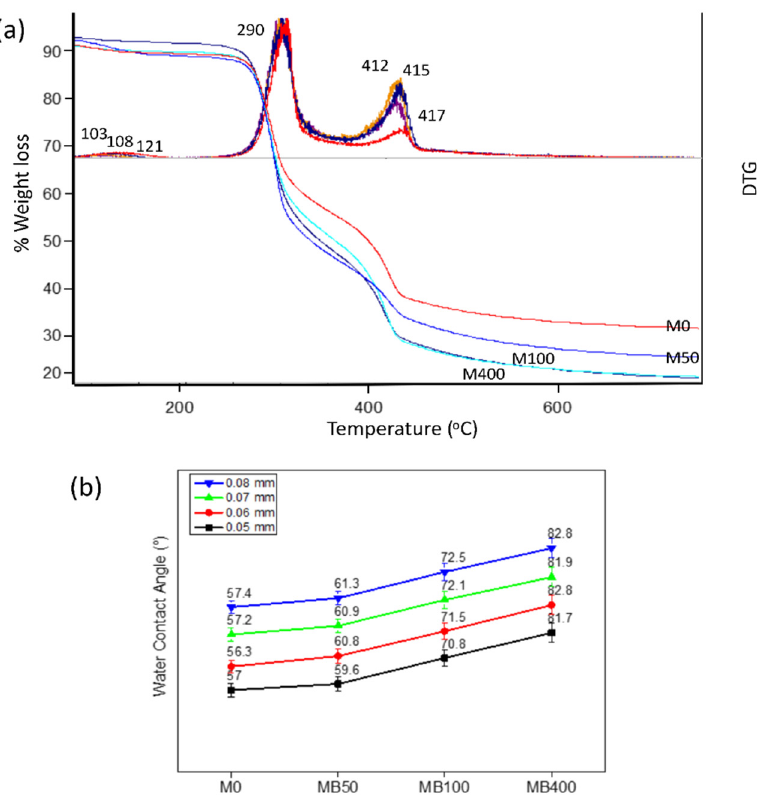
Figure 3. ( a ) Thermogravimetric/differential thermogravimetric (TG/DTG) curves and ( b ) water contact angle values of nanocomposite membranes containing different BKC compositions and different thicknesses.